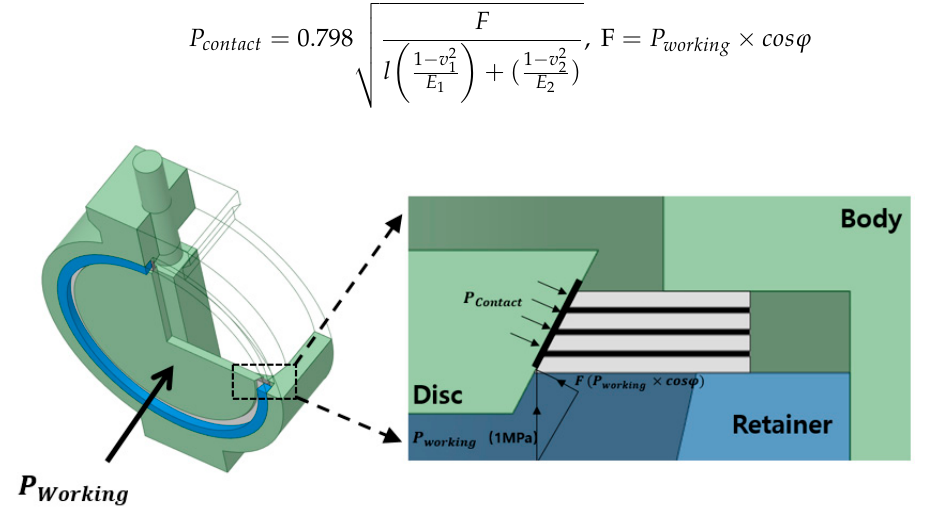
Figure 14. The criterion for leakage.